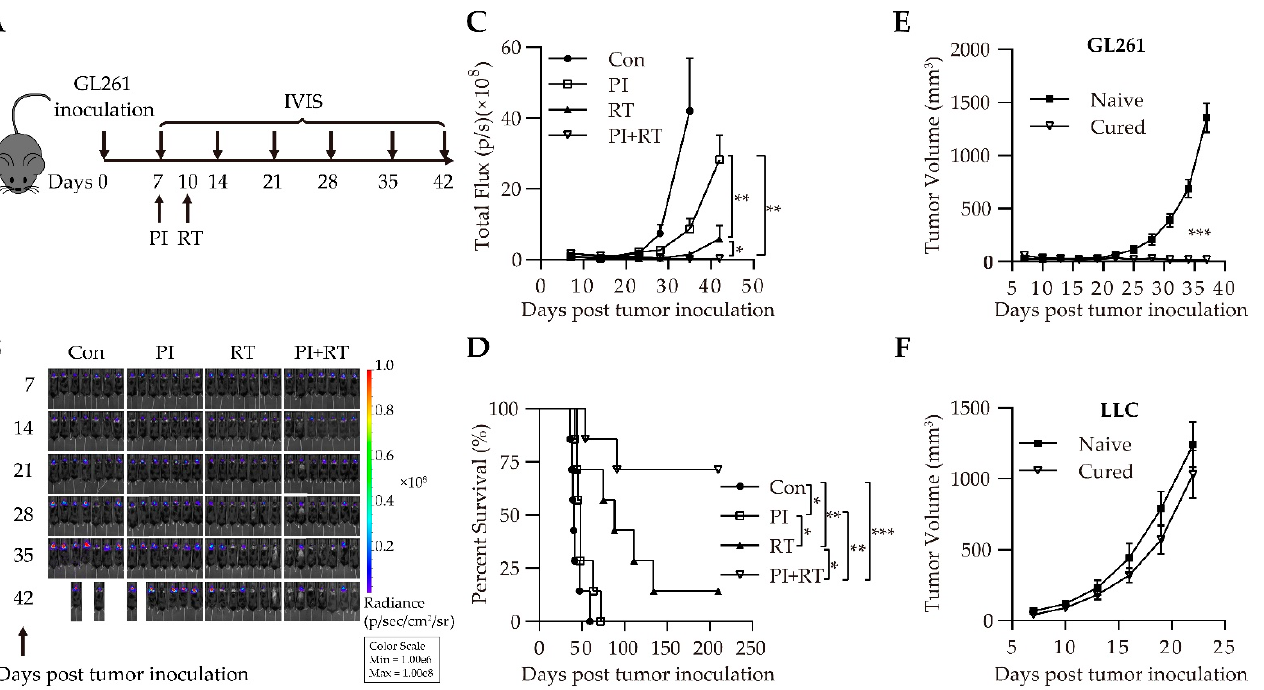
Figure 1. Therapeutic efficacy of PI in combination with RT in orthotopic GL261-Luc glioma model. ( A ) Schematic representation of combination therapy in orthotopic intracerebral GL261-Luc tumor- bearing mice. ( B ) Living imaging for all groups. ( C ) Tumor growth curves based on the data on days 7, 14, 21, 28, 35 and 42 after inoculation of the GL261-Luc cells ( n = 7 per group). Photon-density heat maps were shown for all groups at the same bioluminescence signals. The statistical differences at the experiment endpoint between groups were analyzed with an unpaired two-tailed Student’s t-test. ( D ) The Kaplan-Meier survival curves of mice ( n = 7) were shown and analyzed by a log-rank test. “Cured” mice ( n = 6) were rechallenged with 2 × 10 6 syngeneic GL261-Luc cells ( E ) in the right flank and non-syngeneic 5 × 10 5 LLC cells ( F ) in the left flank. Naïve mice ( n = 6) received the same rechallenges as control. The data showed the mean ± SEM. Statistical differences were indicated by the p values, *, p ≤ 0.05; **, p ≤ 0.01; ***, p ≤ 0.001.